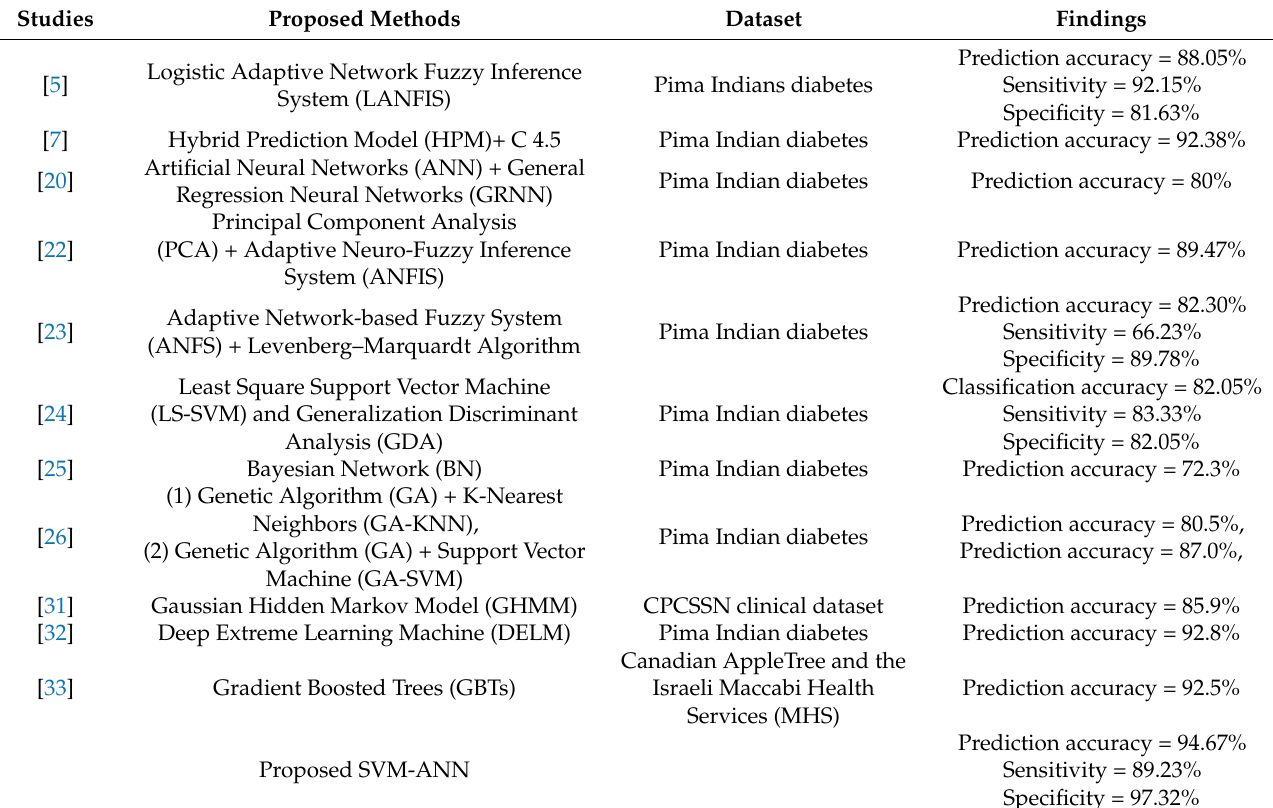
Table 1. Summary of the recent development of Machine Learning for Diabetic